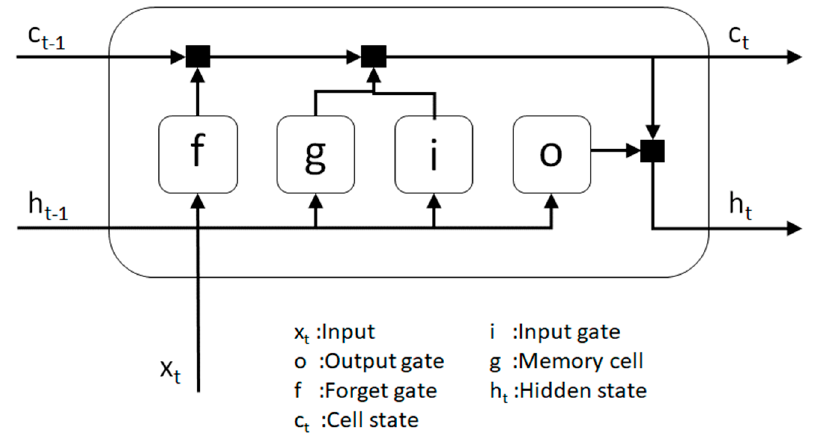
Figure 4. Basic architecture of LSTM cell.